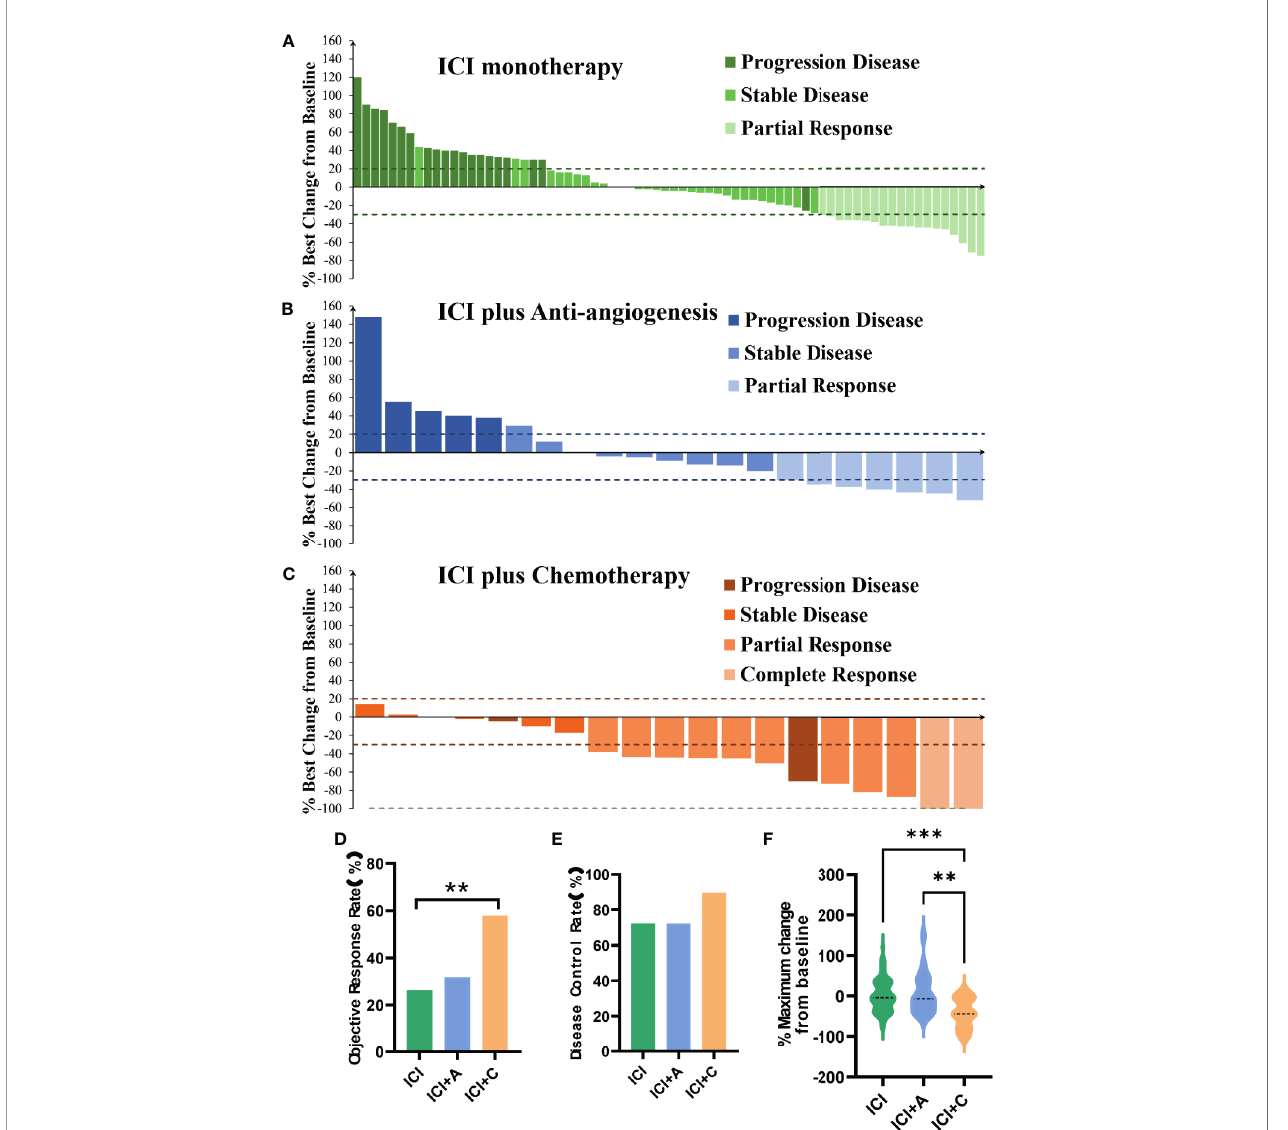
FIGURE 2 | Responses to treatment. Waterfall plots of the treatment response in terms of the greatest change in tumor size compared with the pretreatment size (A – C) in patients treated with ICI monotherapy (green panel), ICI plus an anti-angiogenic agent (ICI+A, blue panel), and ICI plus chemotherapy (ICI+C, orange panel). Each bar represents the greatest reduction in the target lesion size in an individual patient. The dashed lines show the cutoffs used to de fi ne progressive disease ( ≥ 20% increase) and a partial response ( ≥ 30% reduction). The objective response rate (D) , disease control rate (E) , and maximum change compared with pretreatment values (F) in the ICI monotherapy (green), ICI+A (blue), and ICI+C (orange) groups. A complete response, a partial response, stable disease, and progressive disease were estimated using the Response Evaluation Criteria in Solid Tumors criteria, ver. 1.1. ICI, immune checkpoint inhibitor; A, anti-angiogenic agent; C, chemotherapy. **P < 0.01, ***P <